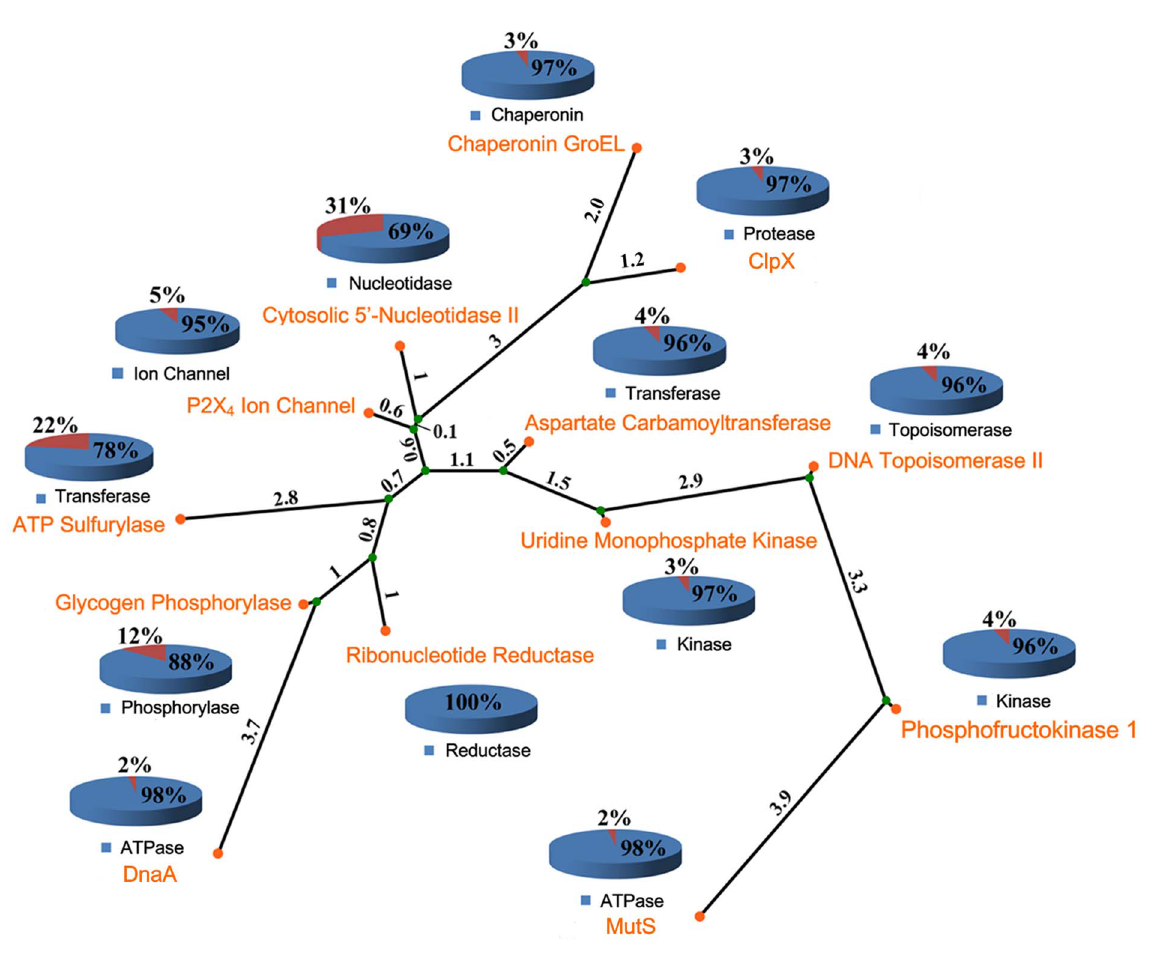
Figure 1. Phylogenetic tree of 13 allosteric proteins. The phylogenetic tree was derived using ClustalX program. The tree structure consists of nodes (represented as circles) and branches (the connecting lines). The internal and external nodes are represented by green and orange circles, respectively. Phylogenetic distance is proportional to branch length. The allosteric proteins belonging to different protein families are depicted in the pie chart. Orange represents the percentage of the number of proteins with a sequence identity greater than 30% when compared to the reported allosteric protein in this protein family deposited in ASD.